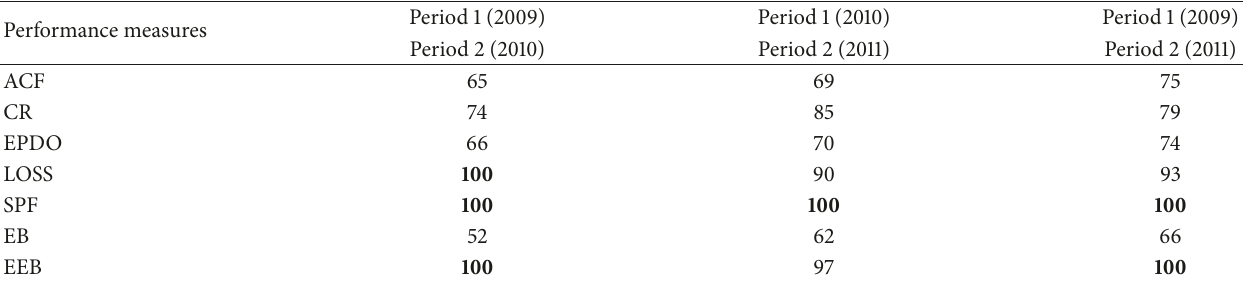
Table 5: Total score tests results for three-time